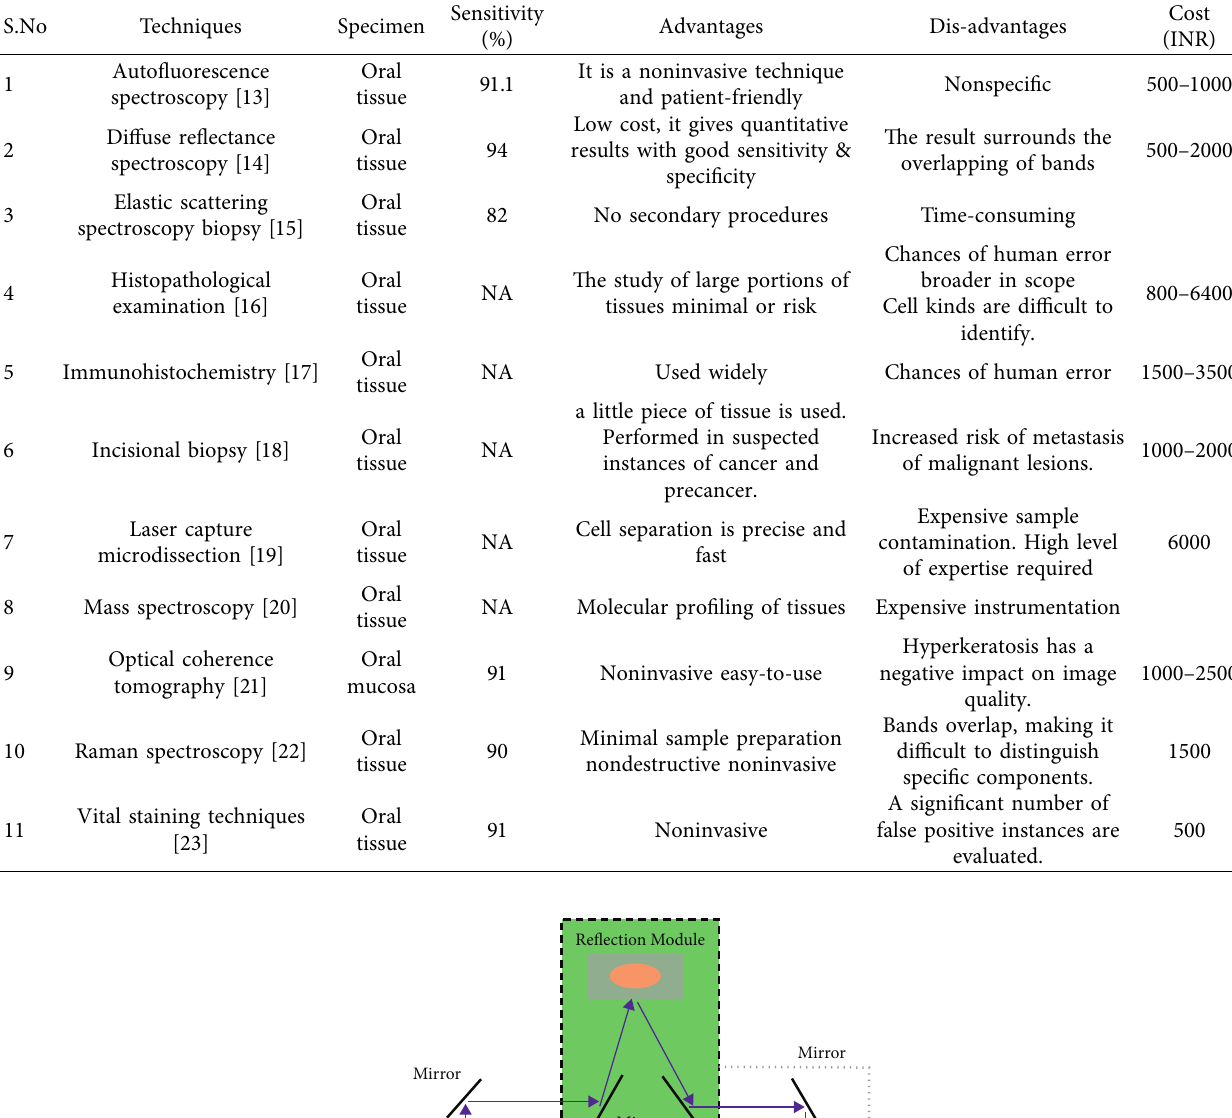
Table 1: Various noninvasive techniques for diagnosing oral tissues.